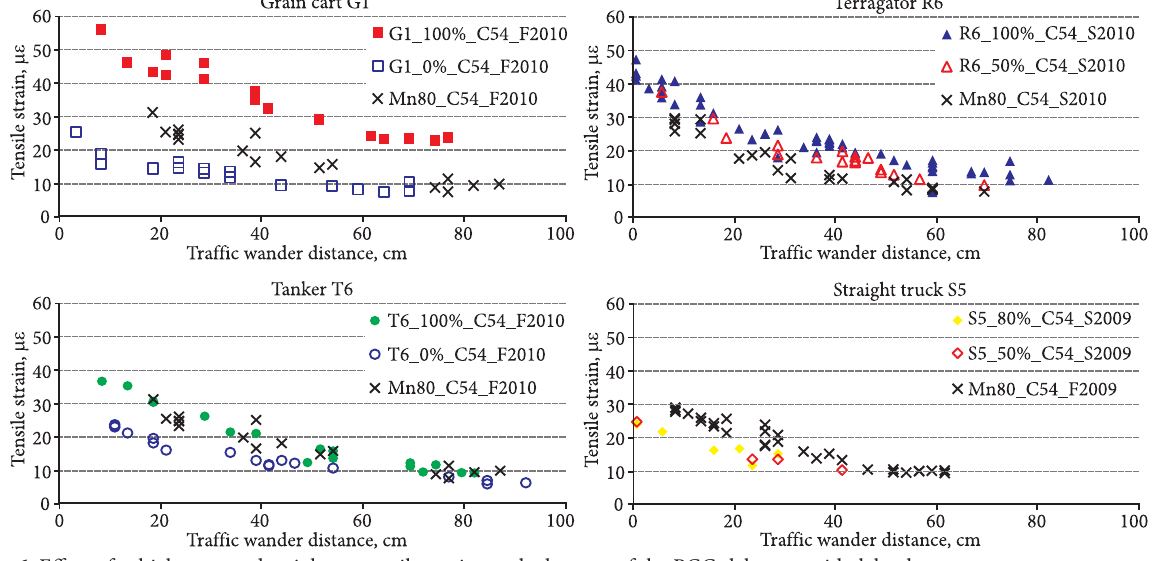
Fig. 6. Effect of vehicle type and weight on tensile strains at the bottom of the PCC slab near mid-slab edge